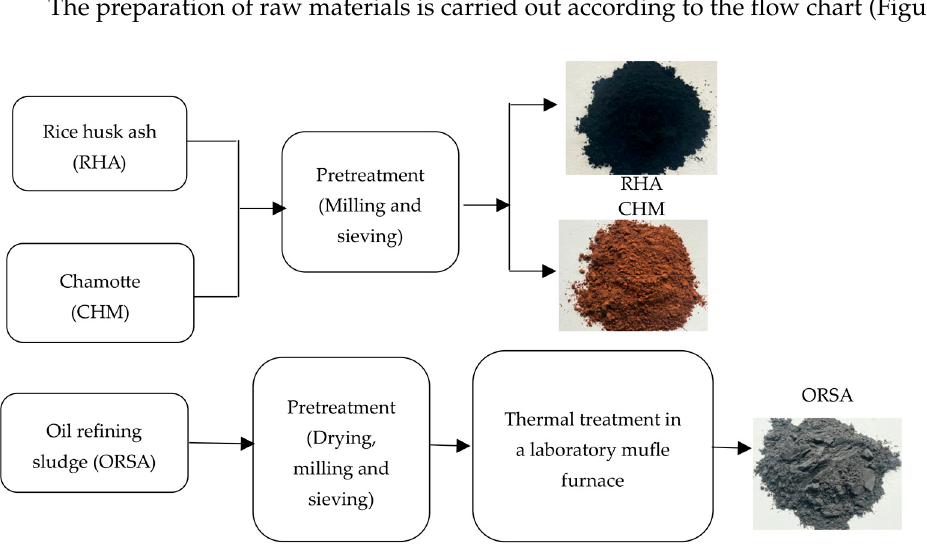
Figure 1. Schematic representation of the preparation of raw materials. The particle size of precursors was determined using a Malvern Mastersizer 2000 (Malvern, UK). The particle size distribution of the precursors is presented in Figure 2. The average particle size of the RHA, CHM and ORSA (D50) is 24.3, 8.0 and 66.9 µm, respectively.